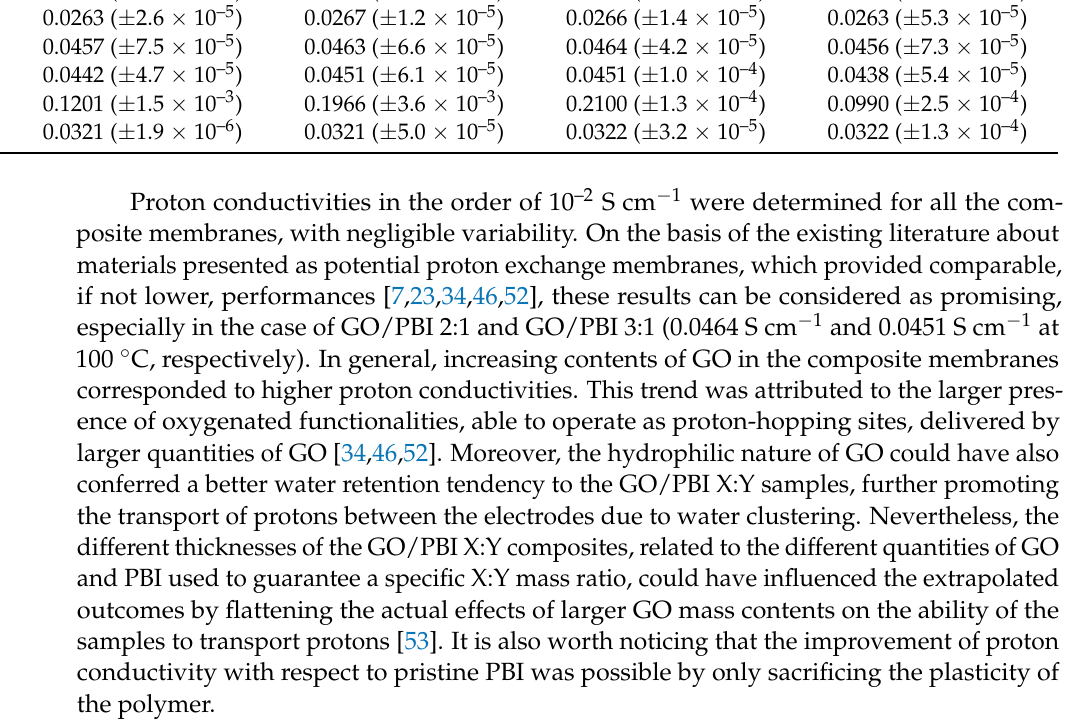
Table 3. Proton conductivity values of GO/PBI X:Y composites, pure GO, and pure PBI from EIS tests executed at 60, 80, 100, and 120 °C.